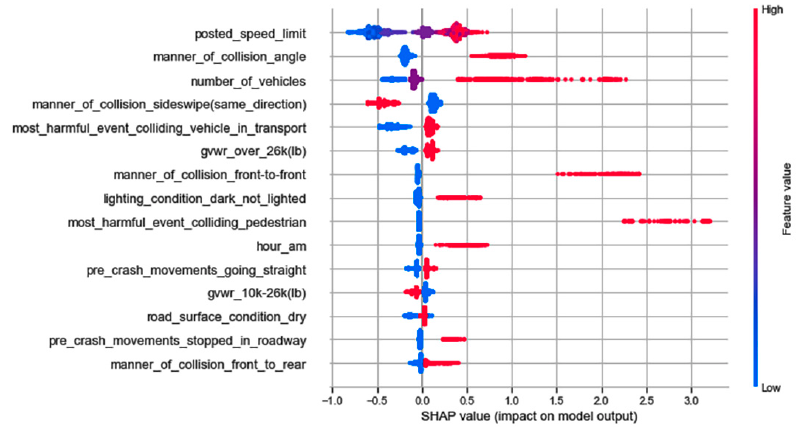
Safety 2021 , 7 , x FOR PEER REVIEW Figure 2. Summary plot for top 15 important features in EDS-based model. Figure 2. Summary plot for top 15 important features in EDS-based model.